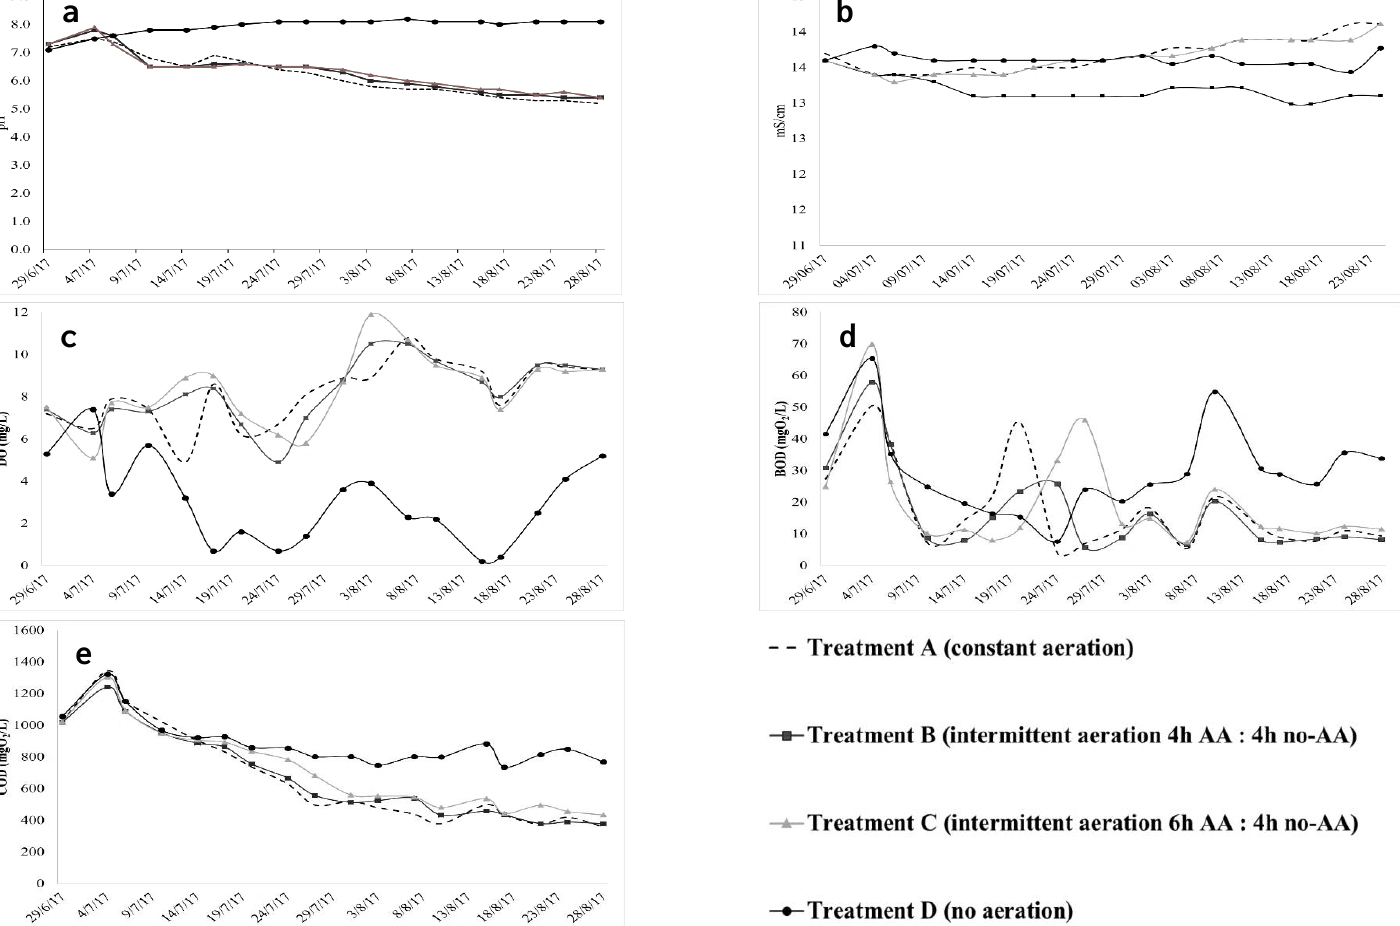
Figure 4. Evolution of ( a ) pH, ( b ) conductivity, ( c ) dissolved oxygen, ( d ) biological oxygen demand, ( e ) chemical oxygen demand in each IBC exposed to different aeration periods. Treatment A (constant aeration), Treatment B (intermittent aeration 4h AA:4h no-AA), Treatment C (intermittent aeration 6h AA:4h no-AA), Treatment D (no aeration), AA= aeration.